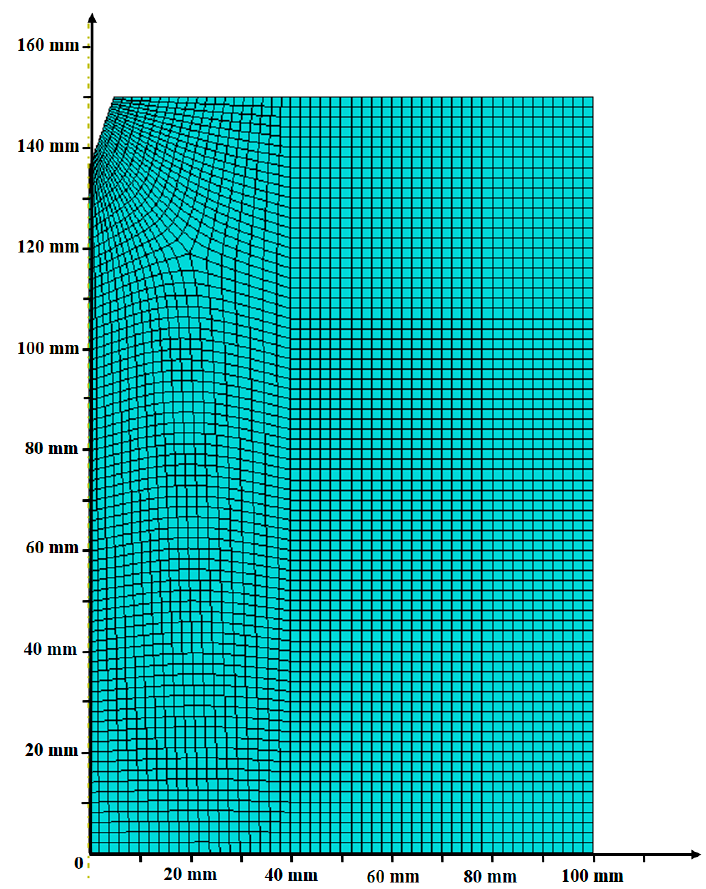
Figure 7. Diagram of grid division.